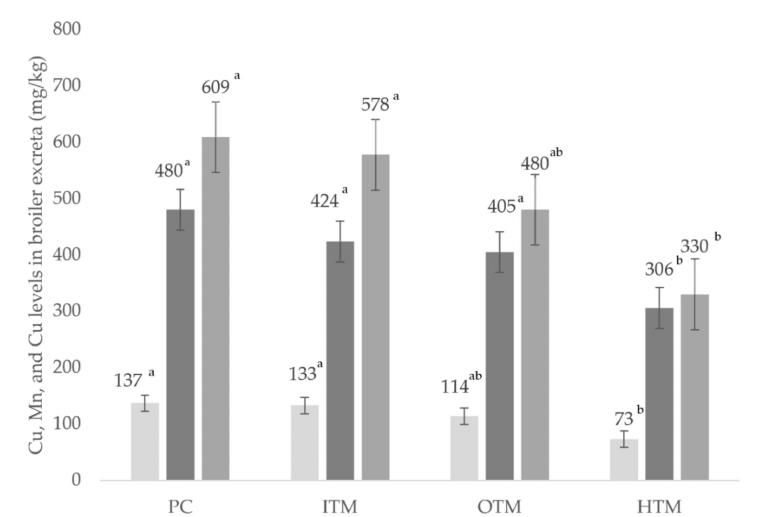
Figure 1. Zinc, manganese, and copper broiler excreta output at 35 days with different levels of supplementation in the feed. PC, positive control; ITM, inorganic trace minerals; OTM, organic trace minerals; HTM, hydroxy trace minerals; a,b minerals in different treatments with different superscripts differ significantly at p < 0.05. n =